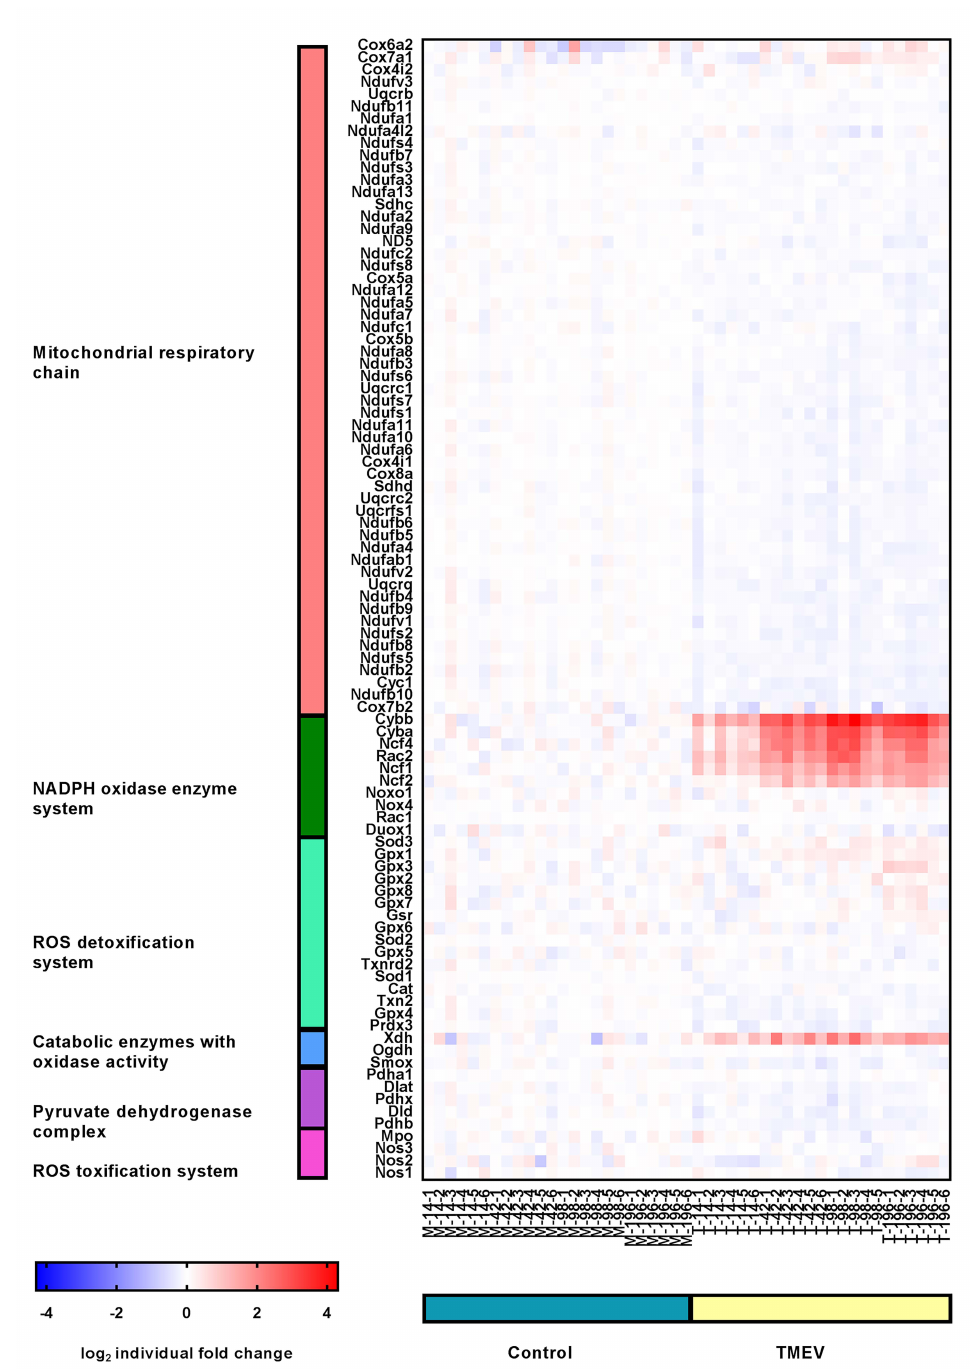
Figure 10. Expression profile of manually selected marker genes (rows) functionally related to mitochondrial respiratory chain (red), NADPH oxidase enzyme system (green), ROS detoxification system (mint), catabolic enzymes with oxidase activity (blue), pyruvate dehydrogenase complex (purple) and ROS toxification system (pink) in the spinal cord (columns) of controls (blue) and TMEV infected mice (brown). Note that the most prominent changes in gene expression are upregulations of genes of the NADPH oxidase enzyme system a ff ecting TMEV infected mice. The heatmap displays the log2-transformed individual fold changes relative to the mean expression of the controls indicated by a color scale ranging from − 4 (16-fold downregulation) in blue to 4 (16-fold upregulation) in